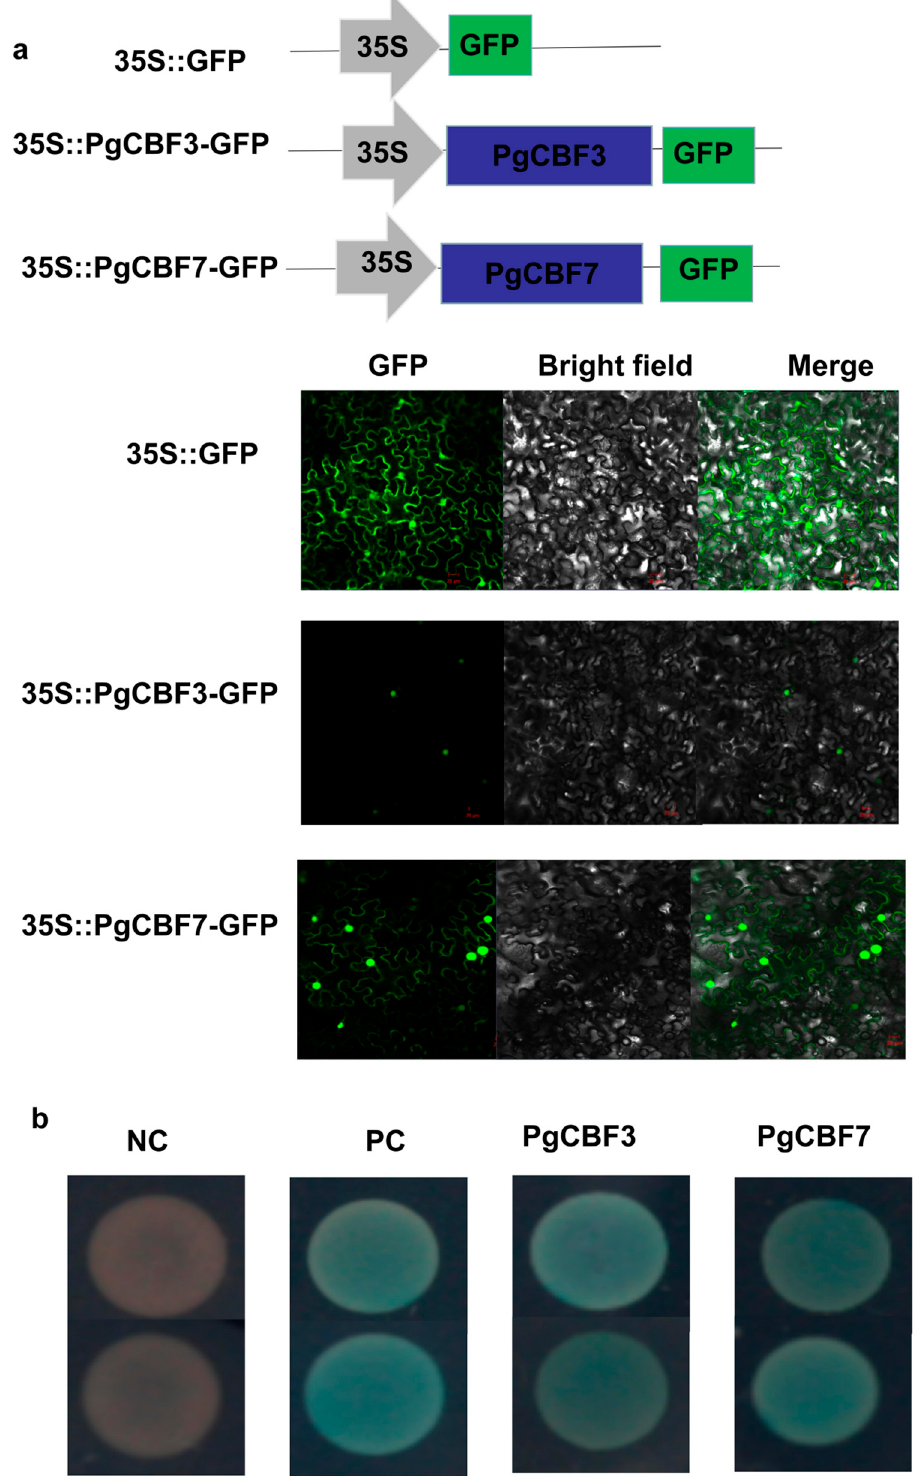
Figure 3. Subcellular localization and transactivation assay of PgCBF3 and PgCBF7. ( a ) Subcellular localization of PgCBF3 and PgCBF7 fusion protein in tobacco epidermal cells; GFP: Green fluorescent protein fluorescence; BF: Bright field; Merge: The fusion of green fluorescence and bright field; Bar = 20 µ m; ( b ) Transcriptional activity analysis of PgCBF3 and PgCBF7 transcription factors. NC: Negative control, pGADT7-T + pGBKT7-Lam; PC: Positive control, pGADT7-T + pGBKT7-p53; PgCBF3: pGADT7-T + pGBKT7-PgCBF3; PgCBF7: pGADT7-T + pGBKT7-PgCBF7.